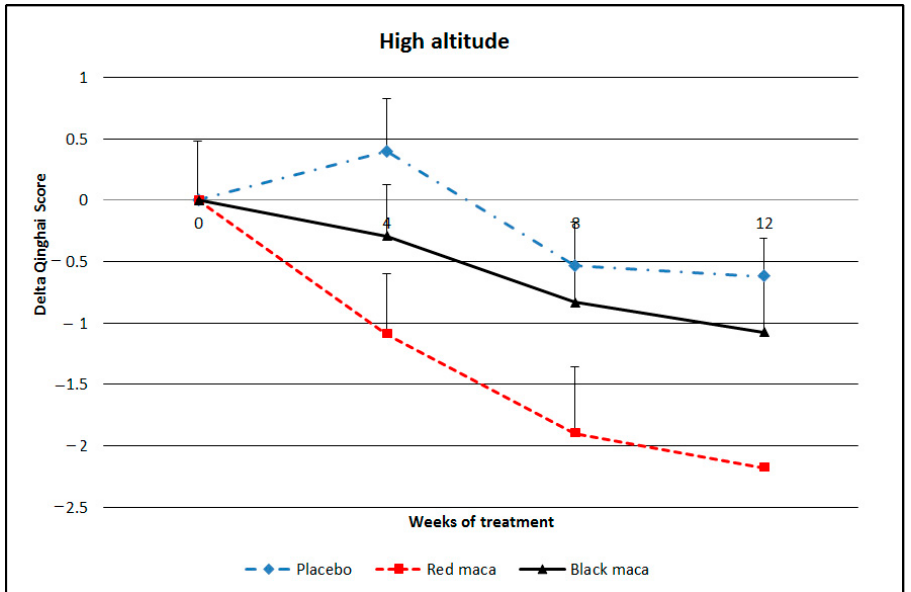
Figure 5. Delta of Qinghai score for Chronic Mountain Sickness (CMS) diagnosis in adult human subjects after a 12-week treatment with spray-dried extract of maca (red or black) or with a placebo at high altitude. Data are mean ± standard error of the mean. Placebo: p > 0.05 over time. Red maca: p < 0.05 at week 4 and p < 0.01 at weeks 8 and 12 with respect to values at time 0. Black maca: p < 0.05 at weeks 8 and 12 with respect to values at time 0. Red maca group: p < 0.05 at weeks 4 and 8 with respect to the placebo and p < 0.01 with respect to the placebo at week